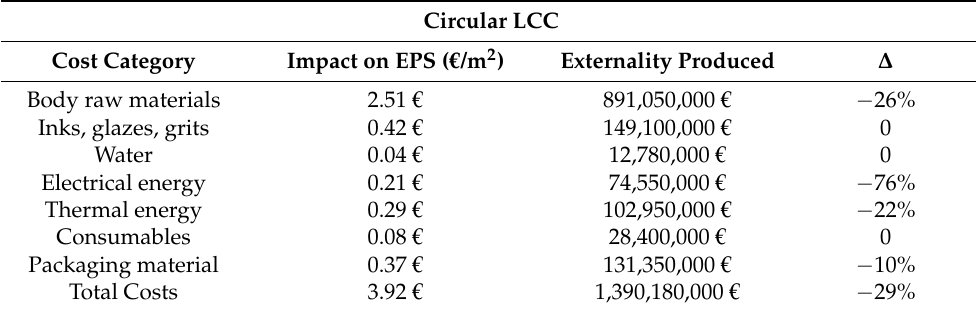
Table 4. Circular LCC analysis (EPS method)—sustainable